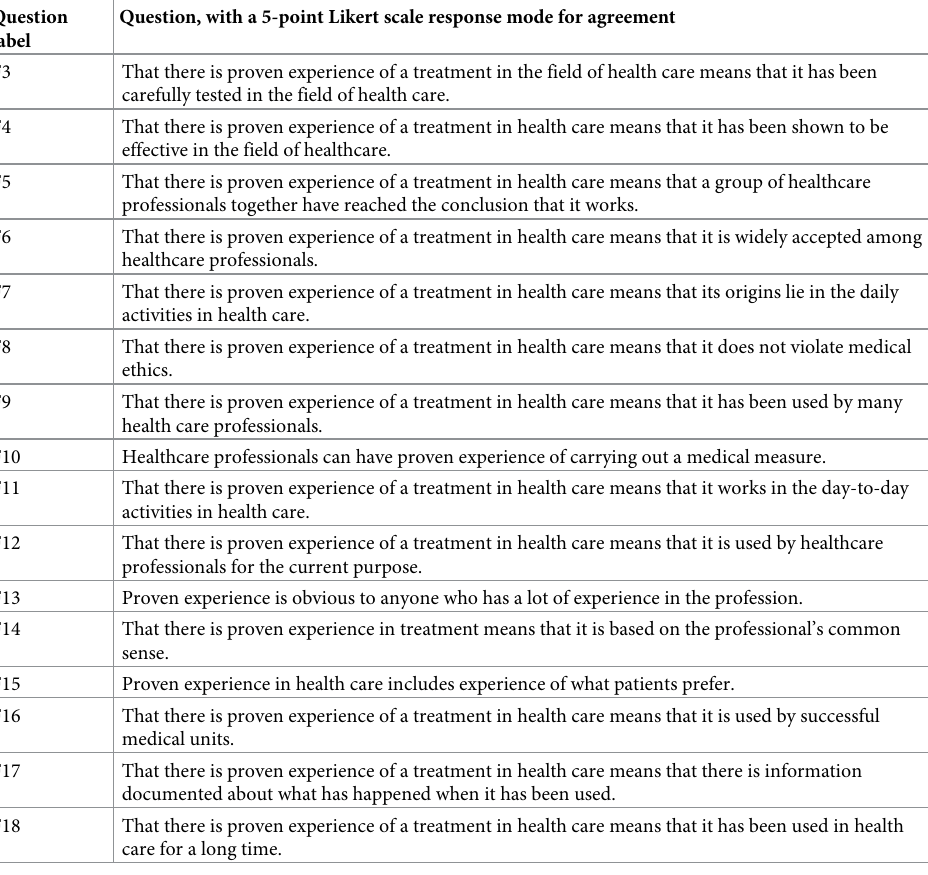
Table 3. Question prompts. Note that the Swedish word for “question” is fråga . Question